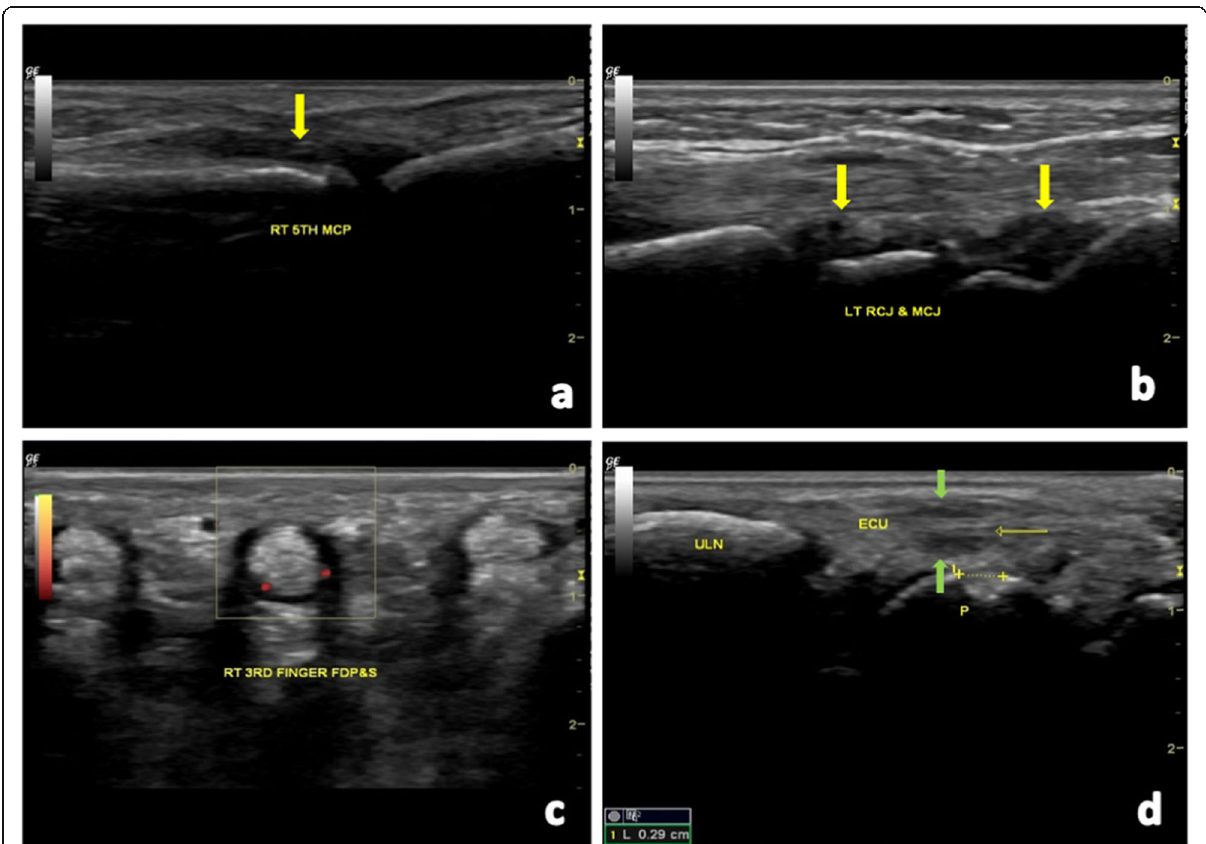
Fig. 1 MSUS of some of present study patients. a Dorsal longitudinal scan of a metacarpophalangeal joint. Yellow arrow indicates joint cavity enlargement due to hypoechoic synovial fluid as well as hyperechoic synovial thickening with bulging over the tops of the periarticular bones (grade 2 synovial hypertrophy). b Dorsal longitudinal scan of radiocarpal and midcarpal joints. Yellow arrows indicate joint cavity enlargement due to hypoechoic synovial fluid as well as hyperechoic synovial thickening (grade 2 synovial hypertrophy). c Volar transverse view of middle finger at metacarpal bone showing flexor tendon sheath widening (grade 2 tenosynovitis). d Dorsal longitudinal scan of a wrist joint showing interruption of cortical bone (erosion) measuring 2.9mm (grade 2). Green arrows indicate distention of extensor carpi-ulnaris sheath involving synovial effusion and synovial hypertrophy (hypoechoic and hyperechoic respectively) (grade 1 tenosynovitis). RT, right; LT, left; RCJ, radio-carpal joint; MCJ, mid-carpal joint; MCP, metacarpophalangeal joint; FDP&S, flexor digitorum profundus and superficialis; ECU, extensor carpi-ulnaris; P,